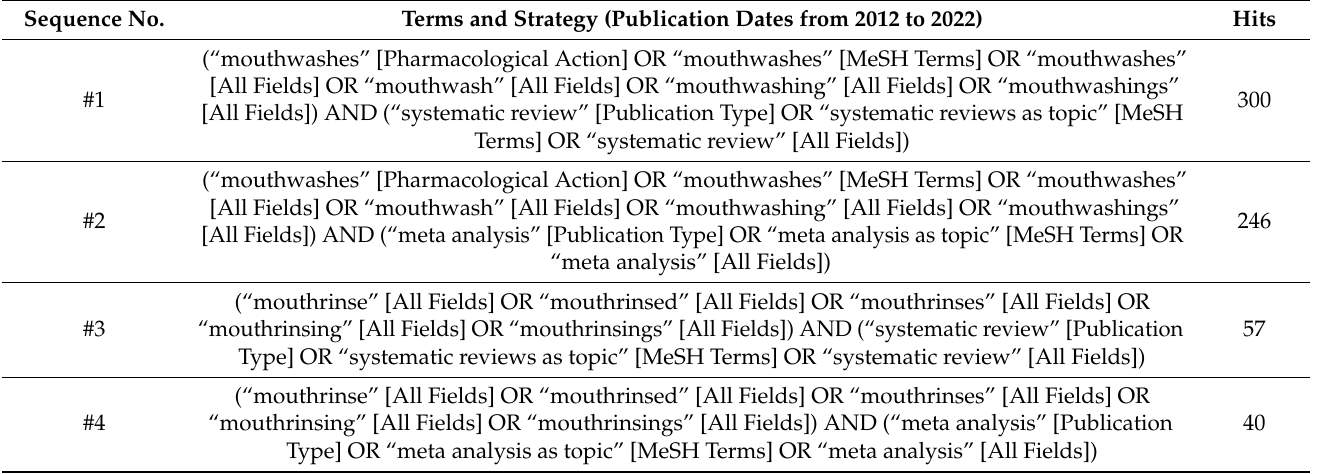
Table 1. A summary of search terms and results in this